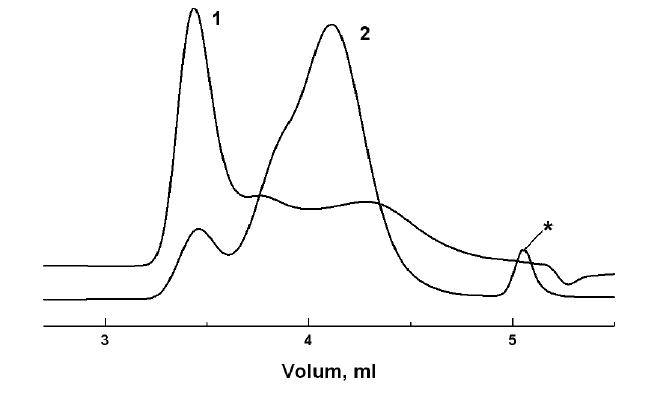
Fig. 6 The SEC-traces of the PB sample (the curve 7 on the Figure 5) after treatment by ¬ - naphtylisocyanate. 1 { the refractometric detector; 2 { the PDA detector, the slice at 290 nm; * { the peak of the ¬ -naphtylethyluretane